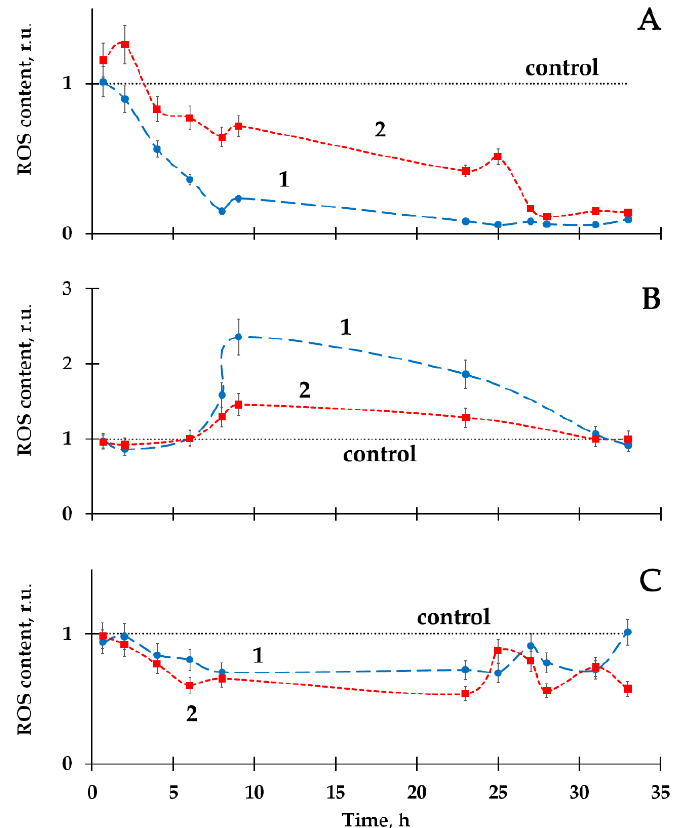
Figure 4. Reactive oxygen species (ROS) content in the bacterial suspensions in HTO in the absence (1) and presence (2) of HS. Specific radioactivities of HTO: ( A ) 2 MBq/L; ( B ) 50 MBq/L; ( C ) 200 MBq/L. HS concentration—10 − 3 g/L. ROS content in the control sample—10 − 6 M.